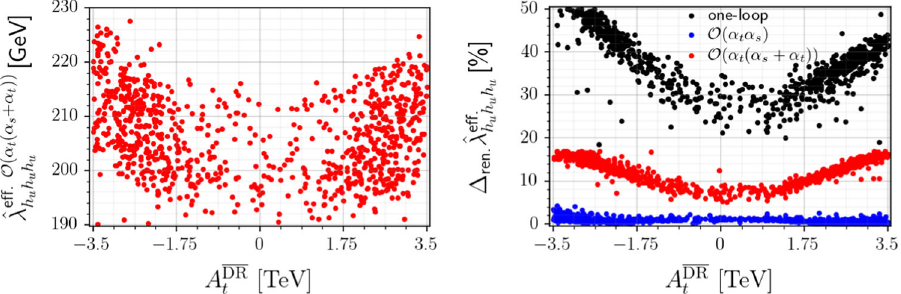
Fig. 5 Left: The effective trilinear self-coupling ˆ λ eff like h u -dominated Higgs mass eigenstate as a function of A DR t at (α + α )) in the OS scheme. Right: The renormalisation scheme O (α t s t